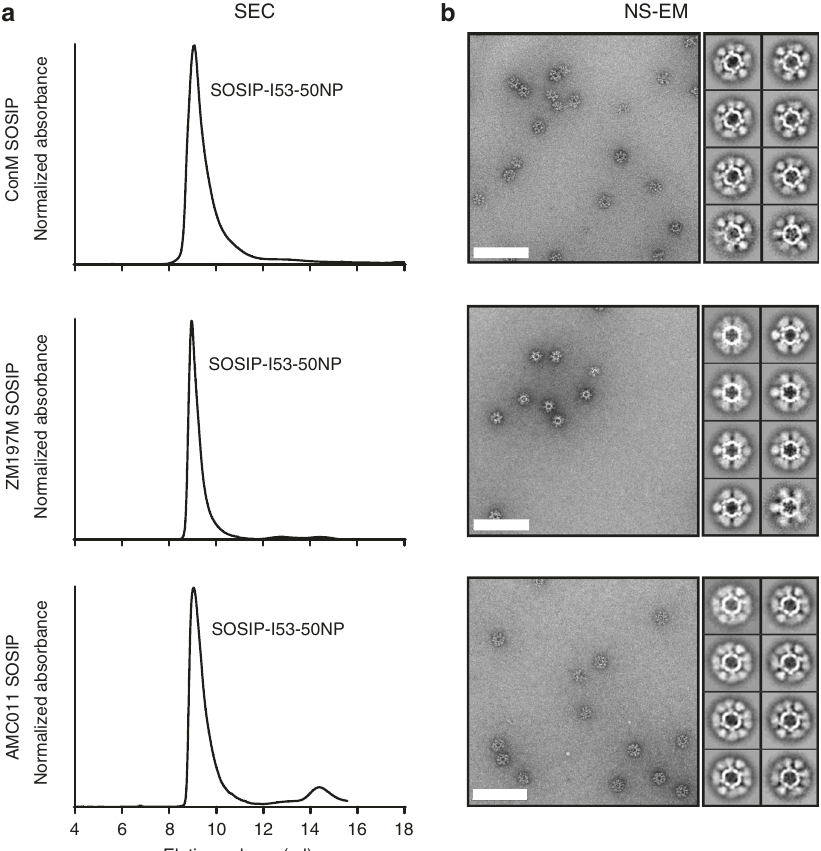
Fig. 3 Characterization of ConM, ZM197M, and AMC011 SOSIP-I53-50NP assembly. a SEC chromatograms of assembled ConM, ZM197, and AMC011 SOSIP-I53-50NPs (from top to bottom). b Raw NS-EM micrographs and 2D-class averages of the pooled SOSIP-I53-50NP fractions corresponding to the SEC chromatogram to the direct left. Particles were subjected to a freeze – thaw cycle prior to NS-EM analysis. The AMC011 SOSIP-I53-50NP solution was mixed 3:1 with Protein Stabilizing Cocktail (ThermoScienti fi c) prior to freezing. The white bar corresponds to 200 nm. Source data are provided as a Source Data fi